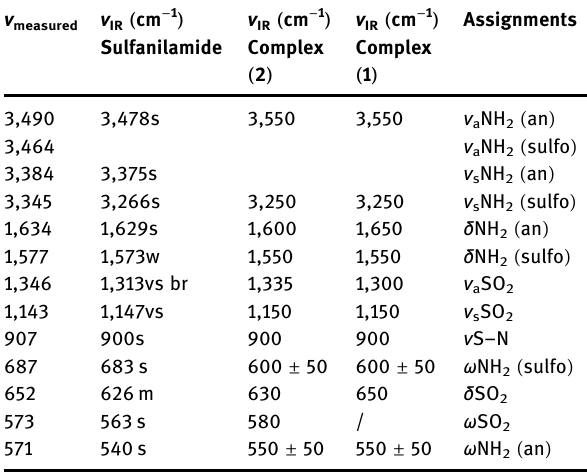
Table 1: Number of calculated vibration waves, positions and assignments for the sulfanilamide and complex ( 1 ) and ( 2 ) mea - sured by infrared ν ν ( cm − 1 ) measured IR Sulfanilamide